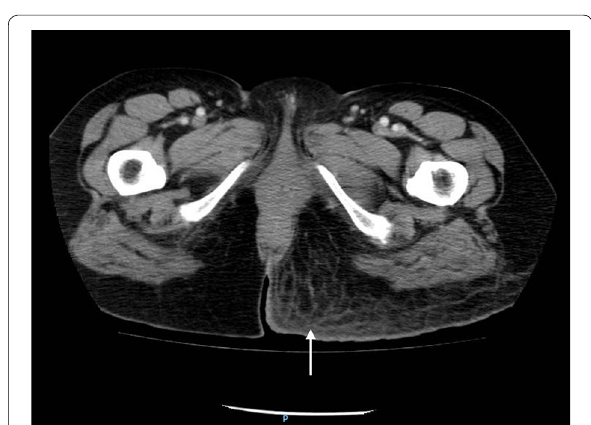
Fig. 3 Contrast CT scan of the lower limbs on day 2 after surgical debridement. Axial tomogram at the level of the proximal thigh showing abnormal enhancement of the subcutaneous and fascial layer of the left gluteal region